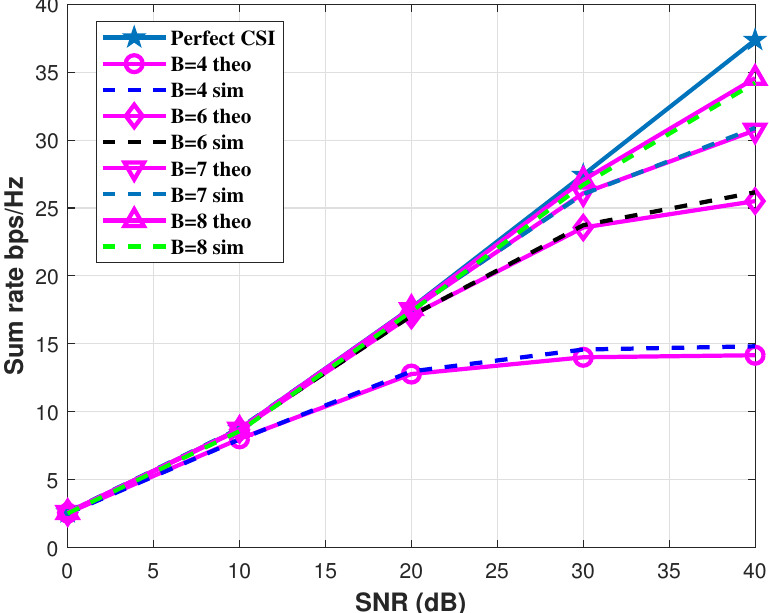
Figure 7. Performance comparison of theoretical and simulation results with SQ-based CSI feedback with different quantization bits in ( 2 × 2,1 )